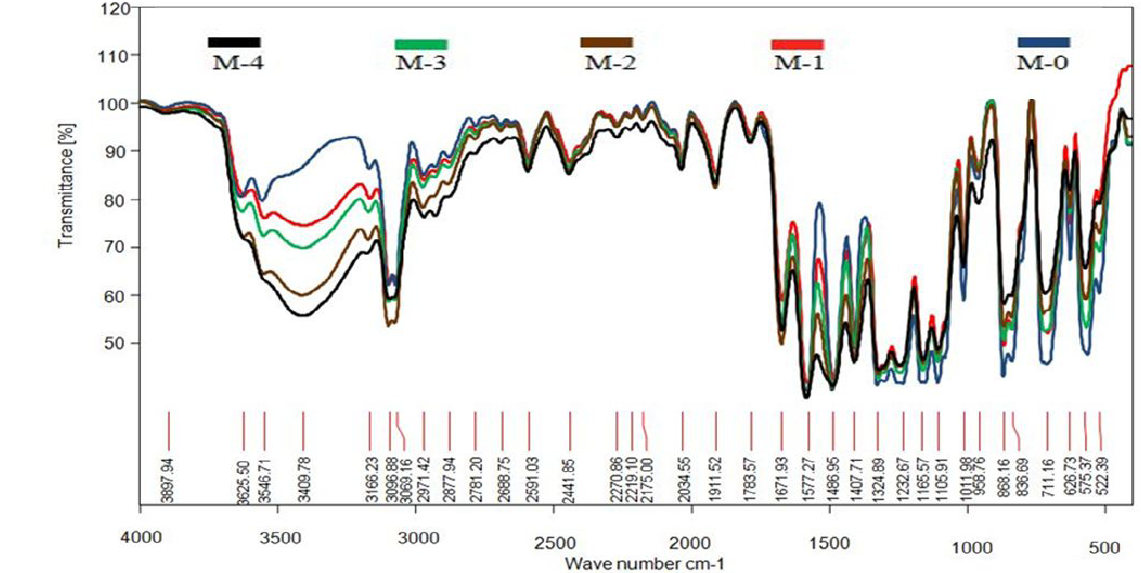
Figure 6. Fourier-transform spectroscopy of the synthesized membranes